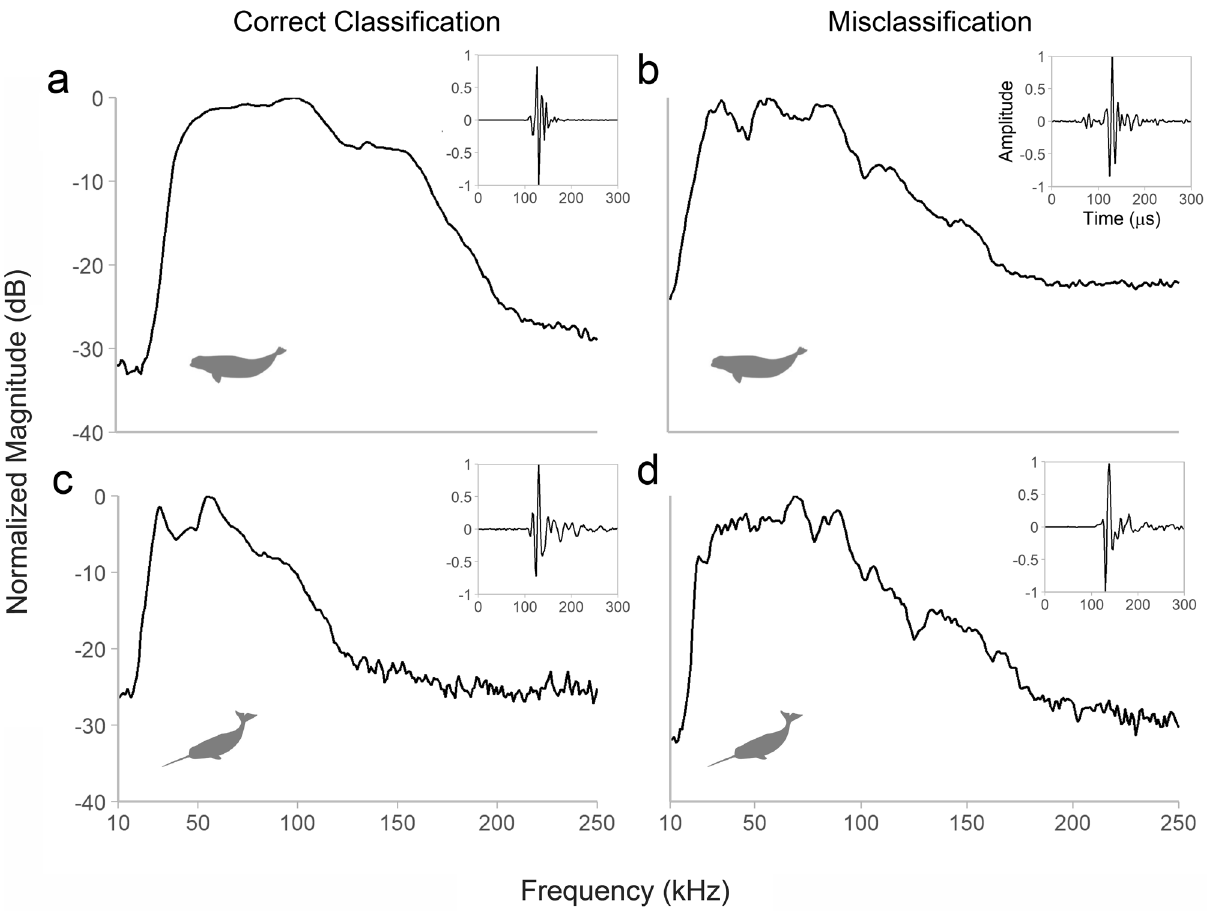
Figure 5. Example average spectra for beluga ( a , b ) and narwhal ( c , d ) acoustic events that were correctly classified ( a , c ) and misclassified ( b , d ). The waveforms of the highest amplitude click for each event are provided. The beluga acoustic event in ( b ) was misclassified by only the RF model and the narwhal acoustic event in ( d ) was misclassified by both the RF and BANTER classification